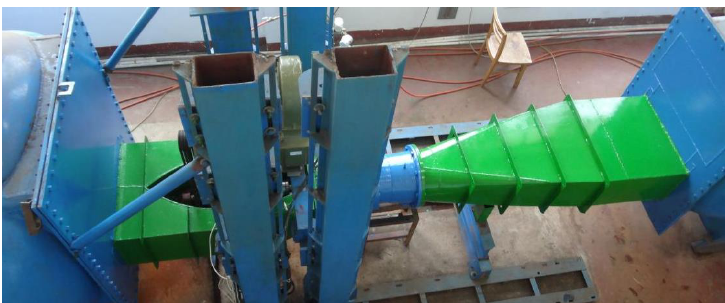
Figure 8. Photo of the model shaft tubular pump device.